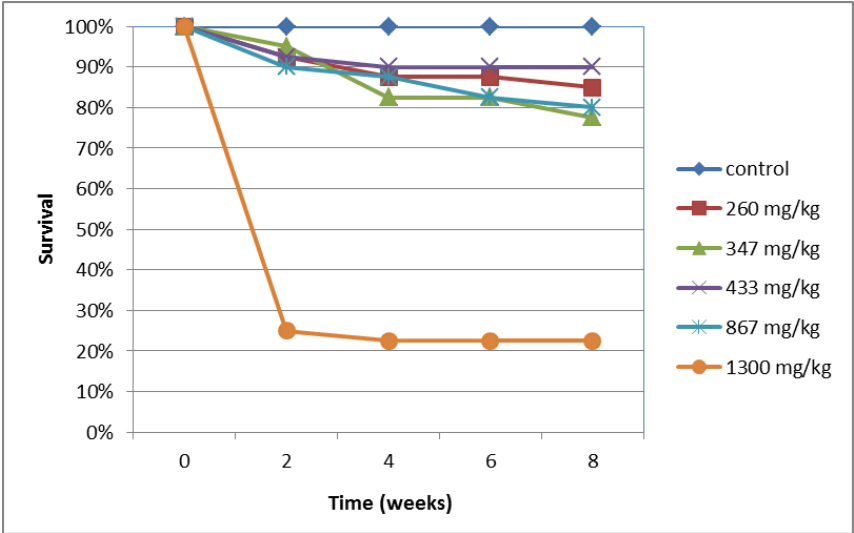
Figure 2. Survival of juvenile earthworms Eisenia fetida in OECD artificial soil exposed to